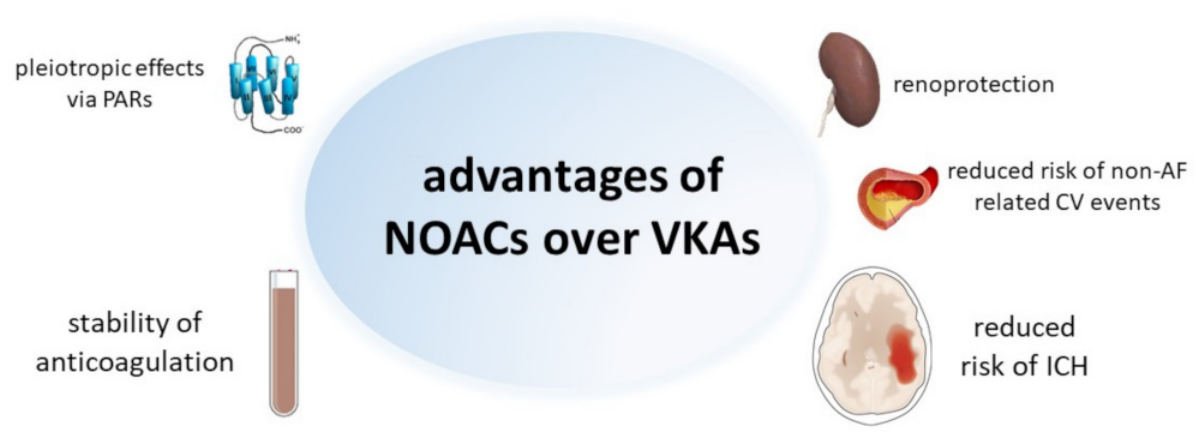
Figure 1. Pharmacological and clinical aspects supporting the use of NOACs over VKAs in patients with AF. AF: atrial fibrillation; ICH: intracranial hemorrhage; PARs: protease-activated receptors. The pictures within the Figure were obtained from Wikimedia Commons and do not have